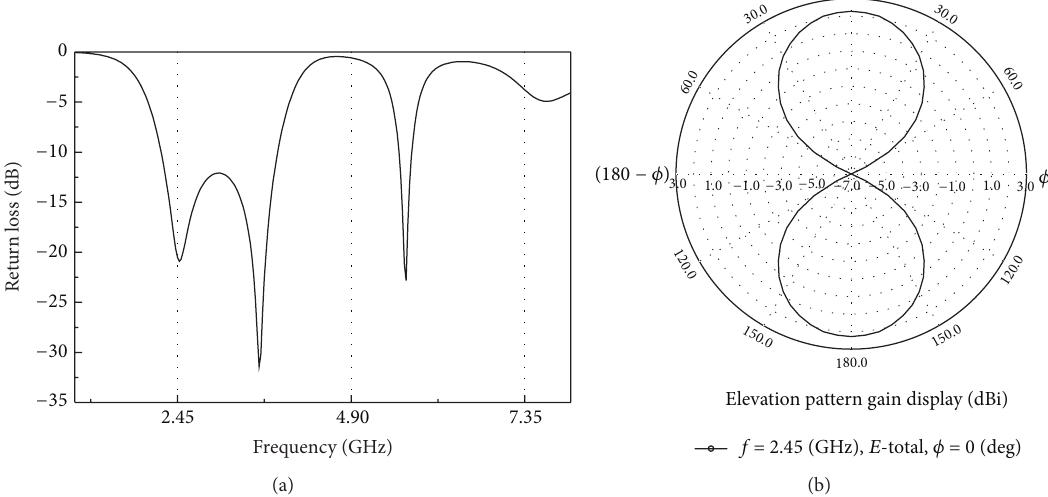
Figure 10: (a) Return loss of the 2.45 GHz rectenna with renormalized port impedance and (b) the simulated rectenna radiation pattern at 2.45